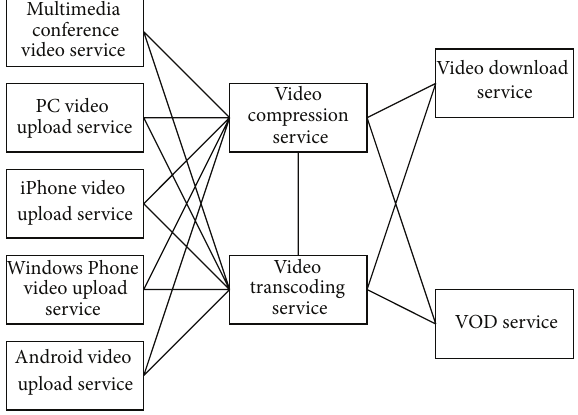
Figure 1: Communication relationship between